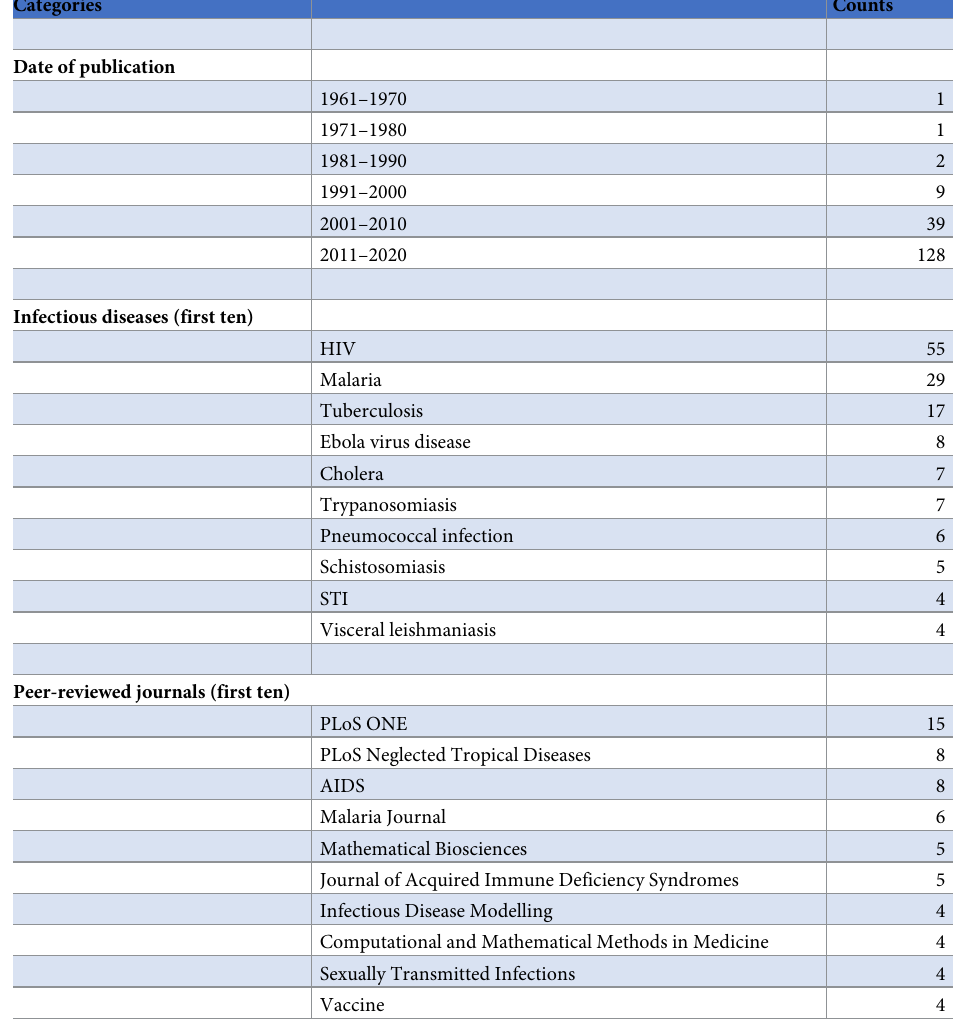
Table 1. The characteristics of the included